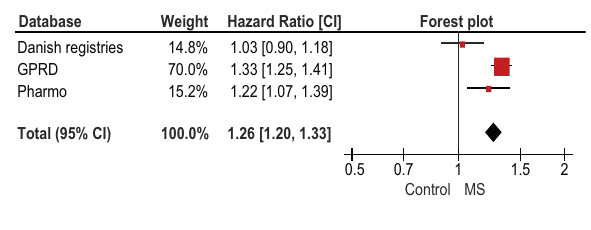
FIGURE 1 | Forest plot of age-sex adjusted Hazard Ratios for any